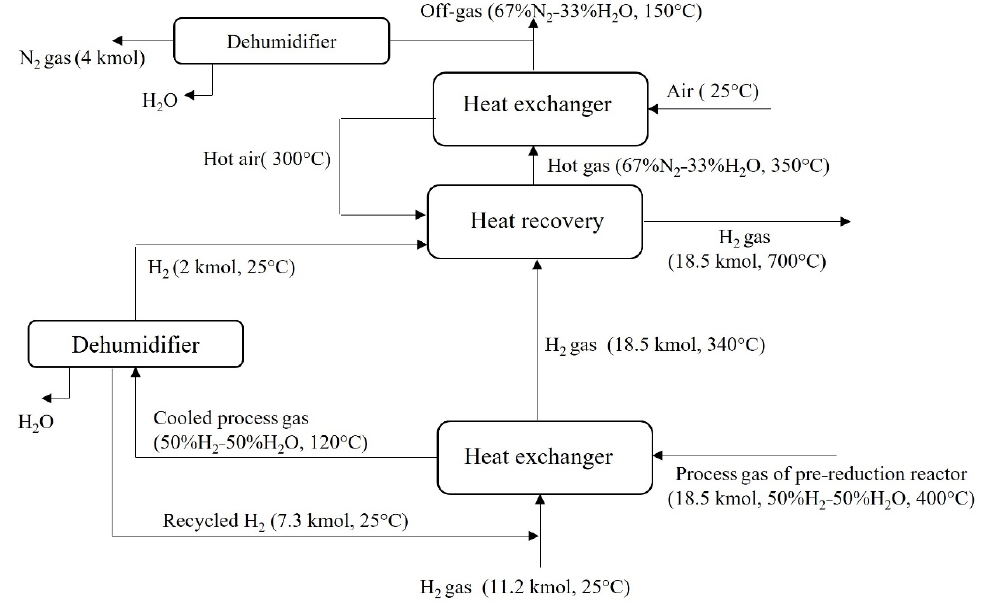
Figure 12. Material flow between units for treating PRR process gas with heat recovery to heat H2 feed gas including H2 looping (Case: Mn metal production).